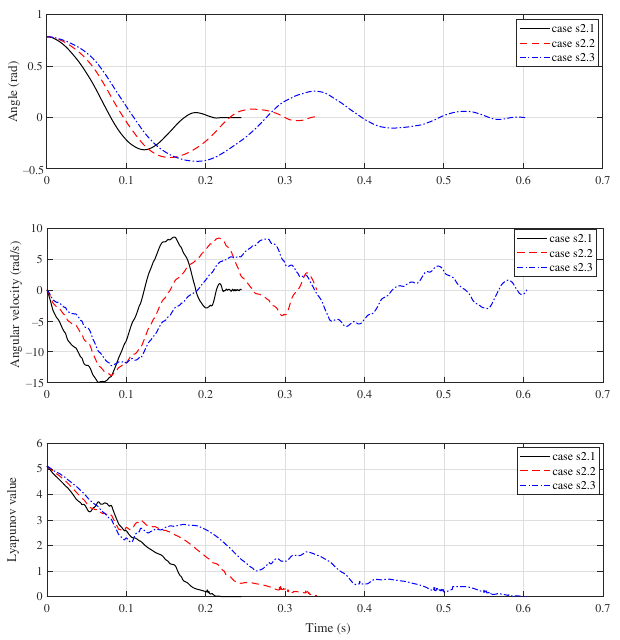
Figure 5. System response of Group